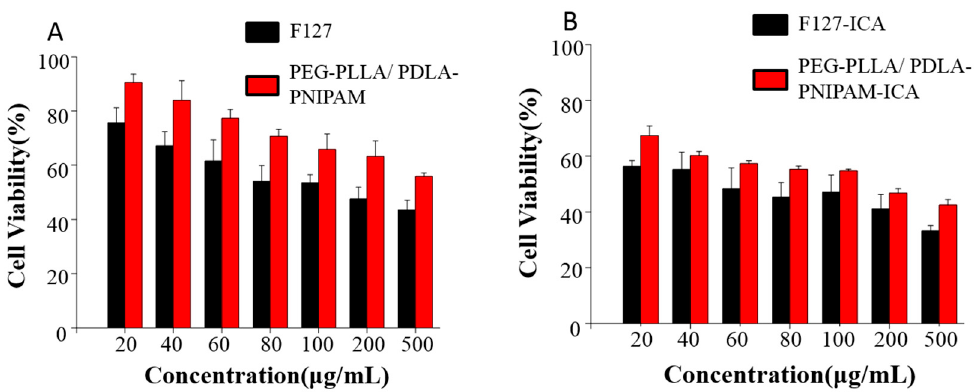
Figure 6. Cell viability of blank micelles ( A ) and drug-loaded micelles ( B ).